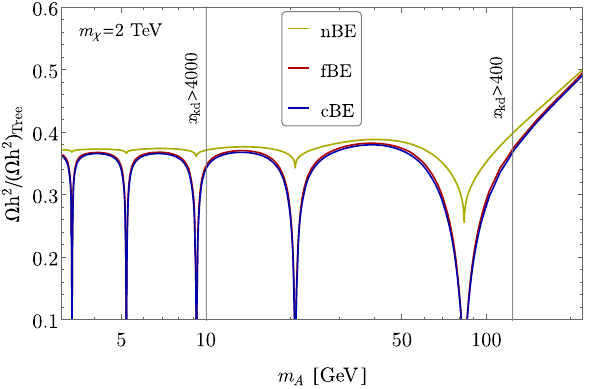
Fig. 5 Relic abundance for the Sommerfeld-enhanced annihilation example, for a fixed DM mass of m χ = 2TeV and as a function of the mediatormass m A .Thecouplingisfixedto α χ = 0 . 07fromtherequire- ment2 (Ω χ h 2 ) Tree = Ω DM h 2 ,basedonthe(velocity-independent)tree- level annihilation cross-section (σv lab ) 0 without Sommerfeld enhance- ment. The predictions from the traditional nBE computation clearly demonstrate the impact of the Sommerfeld effect on the annihilation rate, while the improved calculations based on cBE and fBE quantify the additional impact of kinetic decoupling on the relic abundance